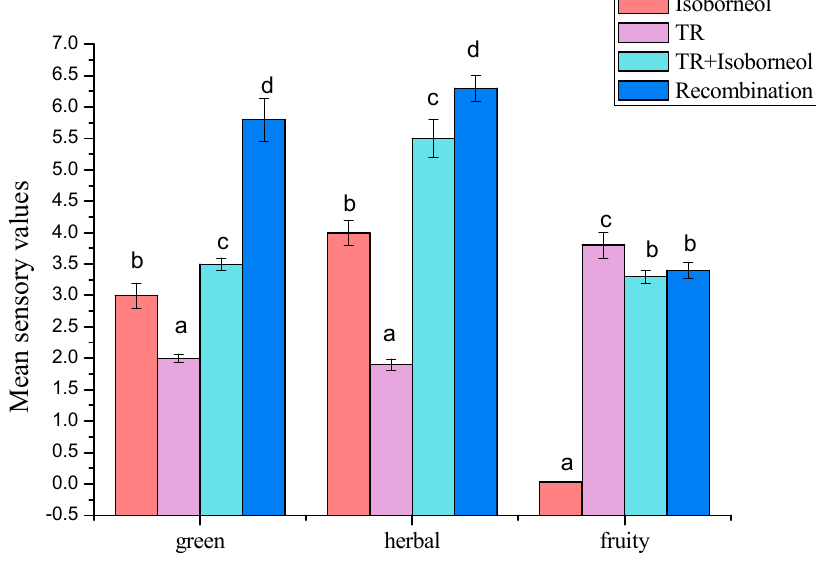
Figure 7. Results of sensory analysis of four samples.